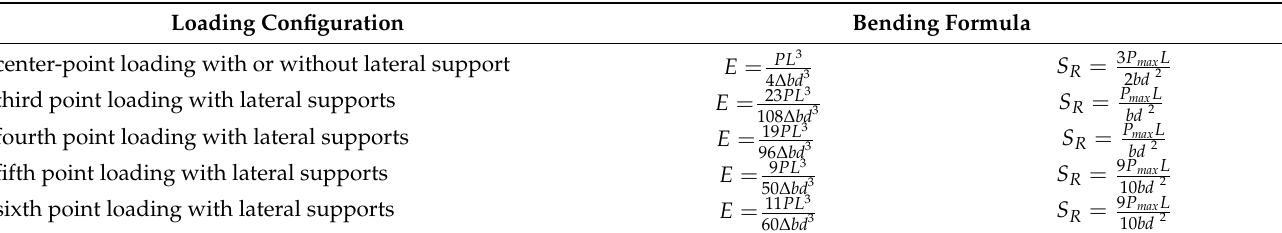
Table 1. The simply supported beam bending formula.